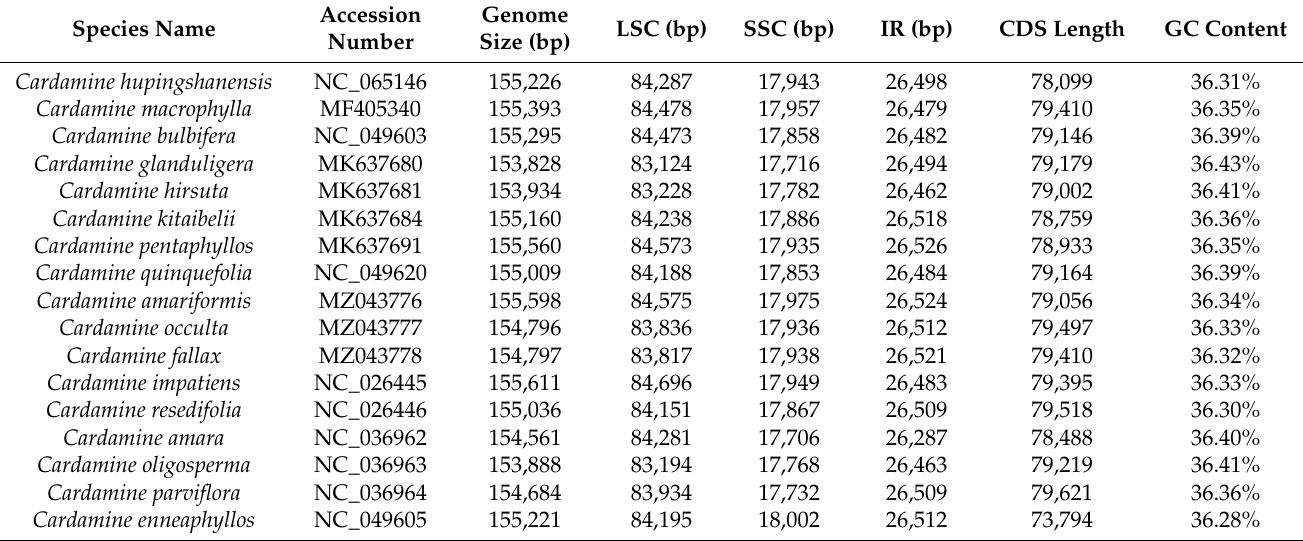
Table 1. Summary of eighteen Cardamine chloroplast genome features.